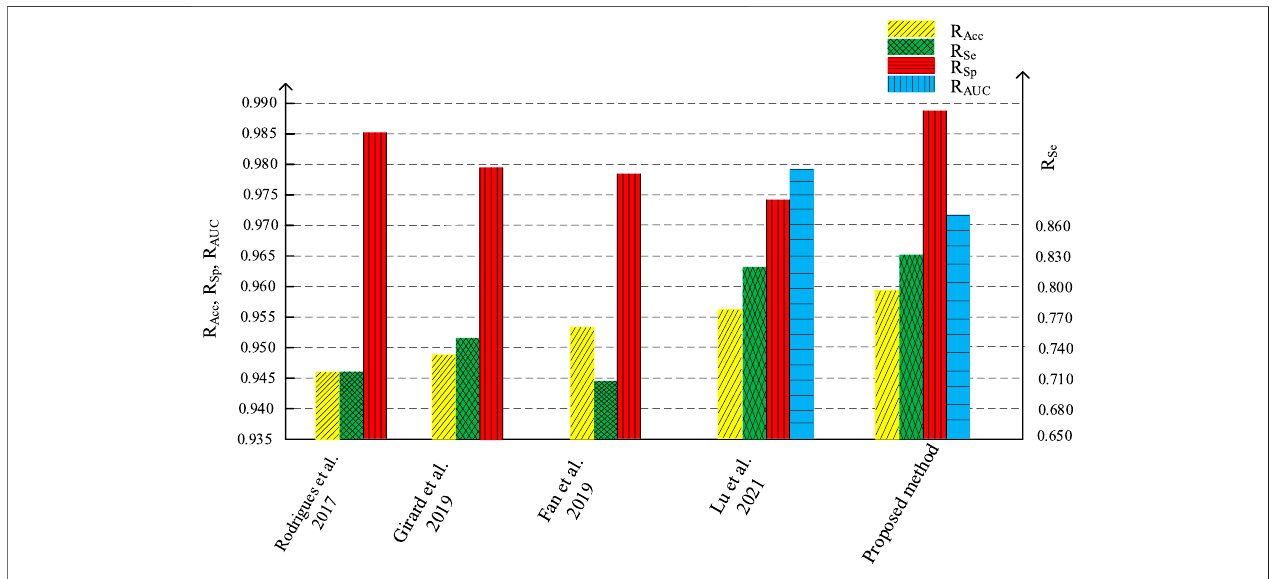
FIGURE 16 | Comparations of evaluation indicators with different algorithm on